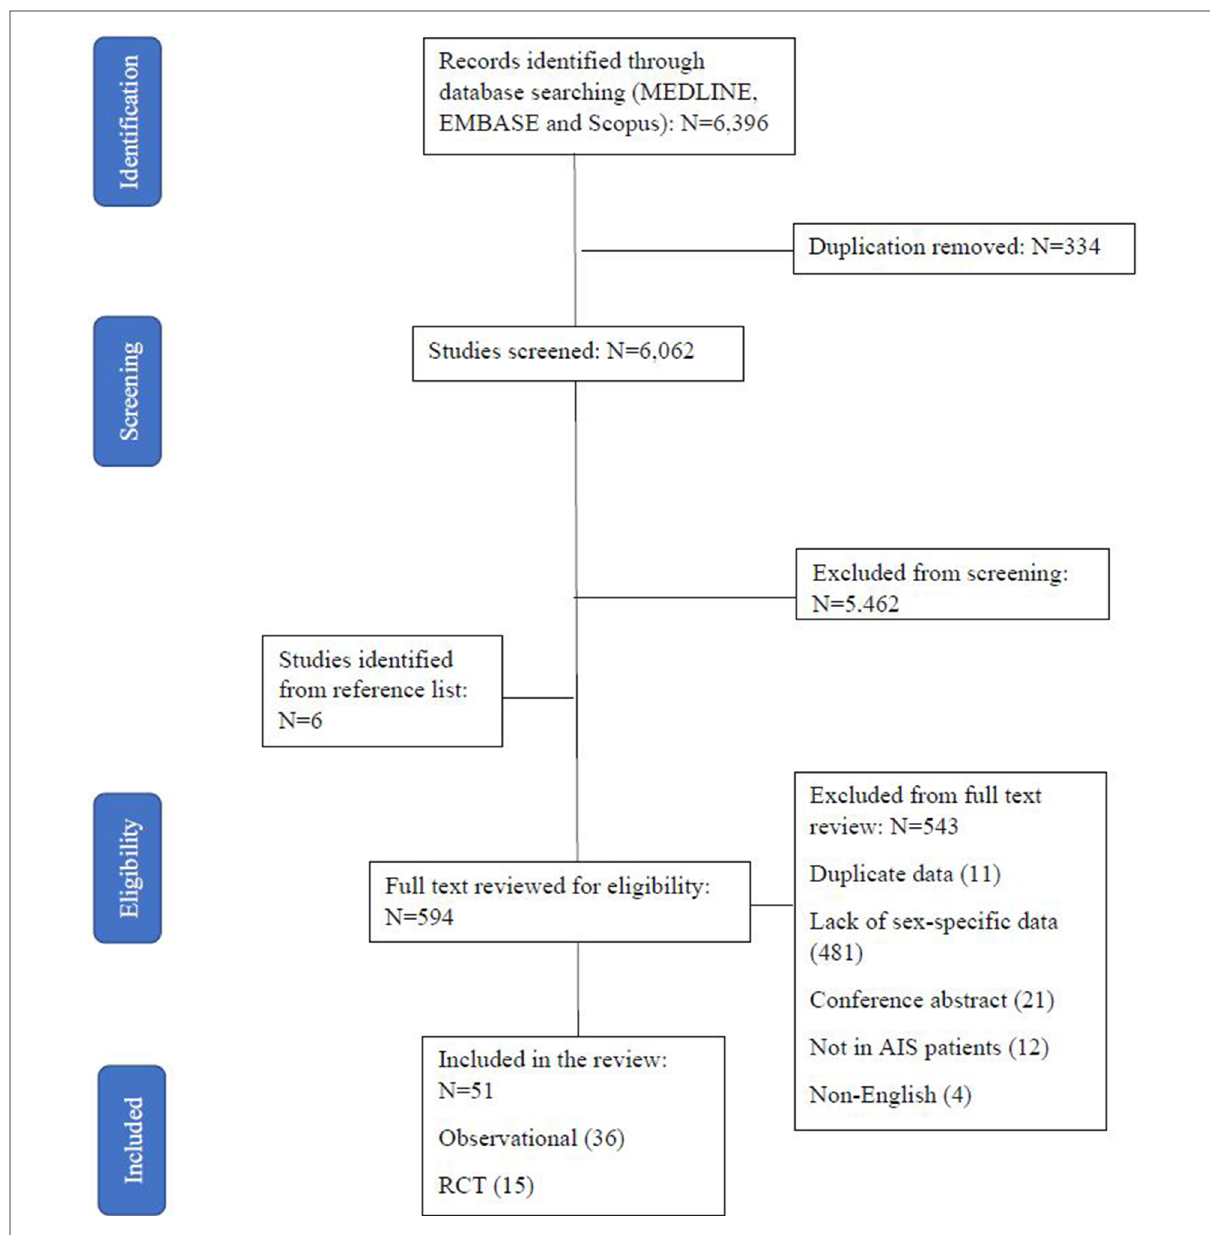
FIGURE 1 PRISMA fl ow diagram including reasons for exclusion of full-text